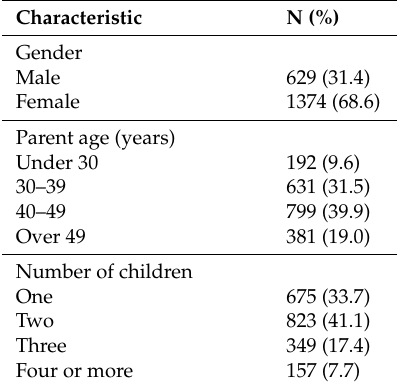
Table 2. Demographic characteristics of respondents (N =